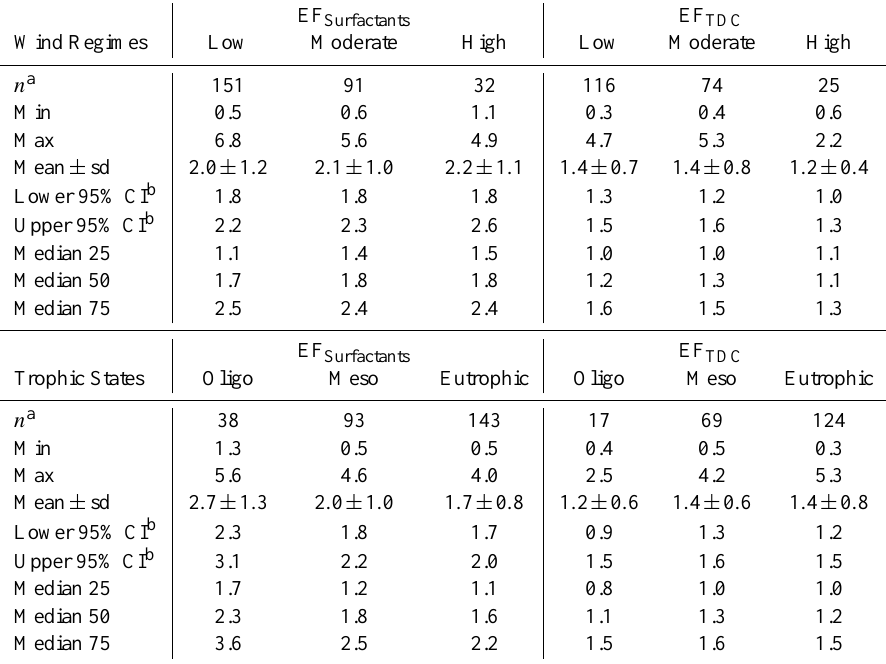
Table 2. Statistical data on enrichment factors (EF) of surfactants and total dissolved carbohydrates (TDC) in the microlayer at different wind regimes and trophic